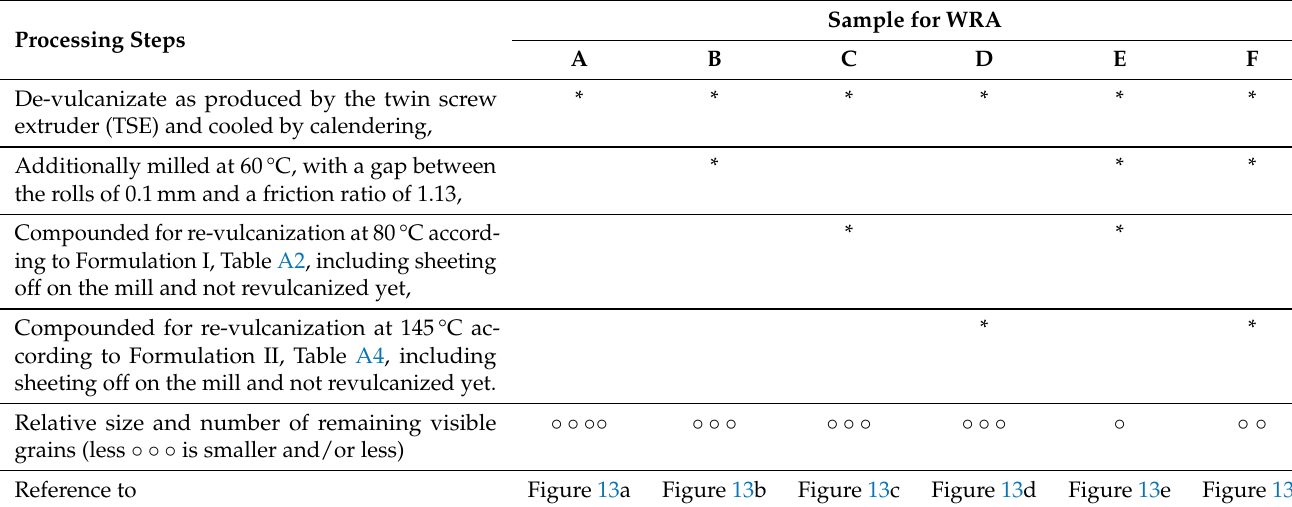
Table 6. Summary of investigated processing steps after de-vulcanization with respect to the influence on particle size as indicated by WRA, as shown in Figure